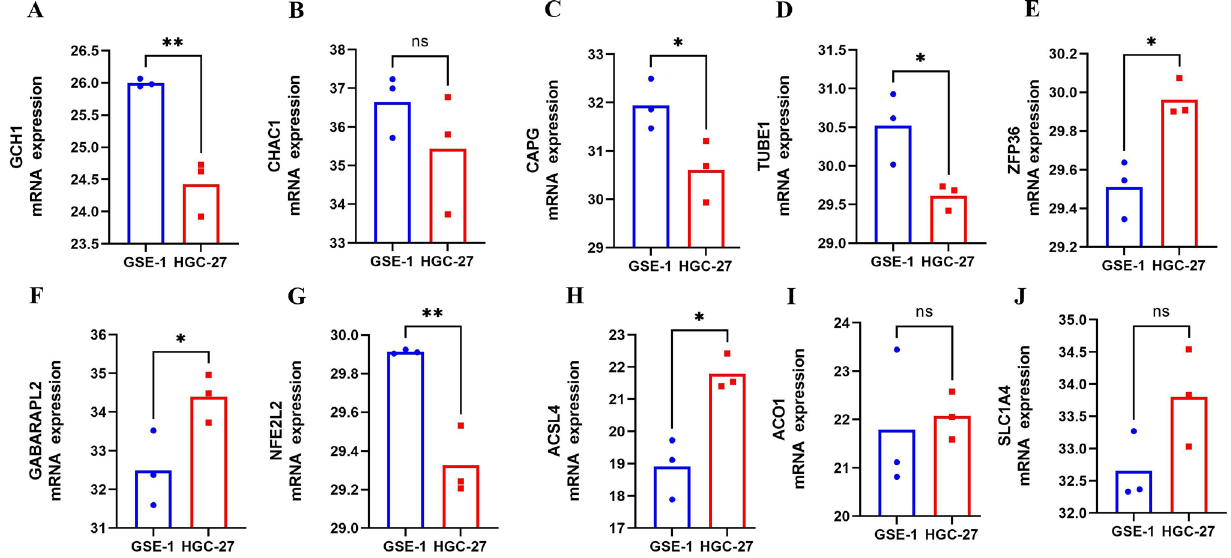
Figure 11. mRNA expression level of FRPGs. mRNA expression level of ( A ) GCH1, ( B ) CHAC1, ( C ) CAPG, ( D ) TUBE1, ( E ) ZFP36, ( F ) GABARAPL2, ( G ) NFE2L2, ( H ) ACSL4, ( I ) ACO1, and ( J ) SLC1A4 by qRT-PCR (* p < 0.05; ** p < 0.01; *** p <